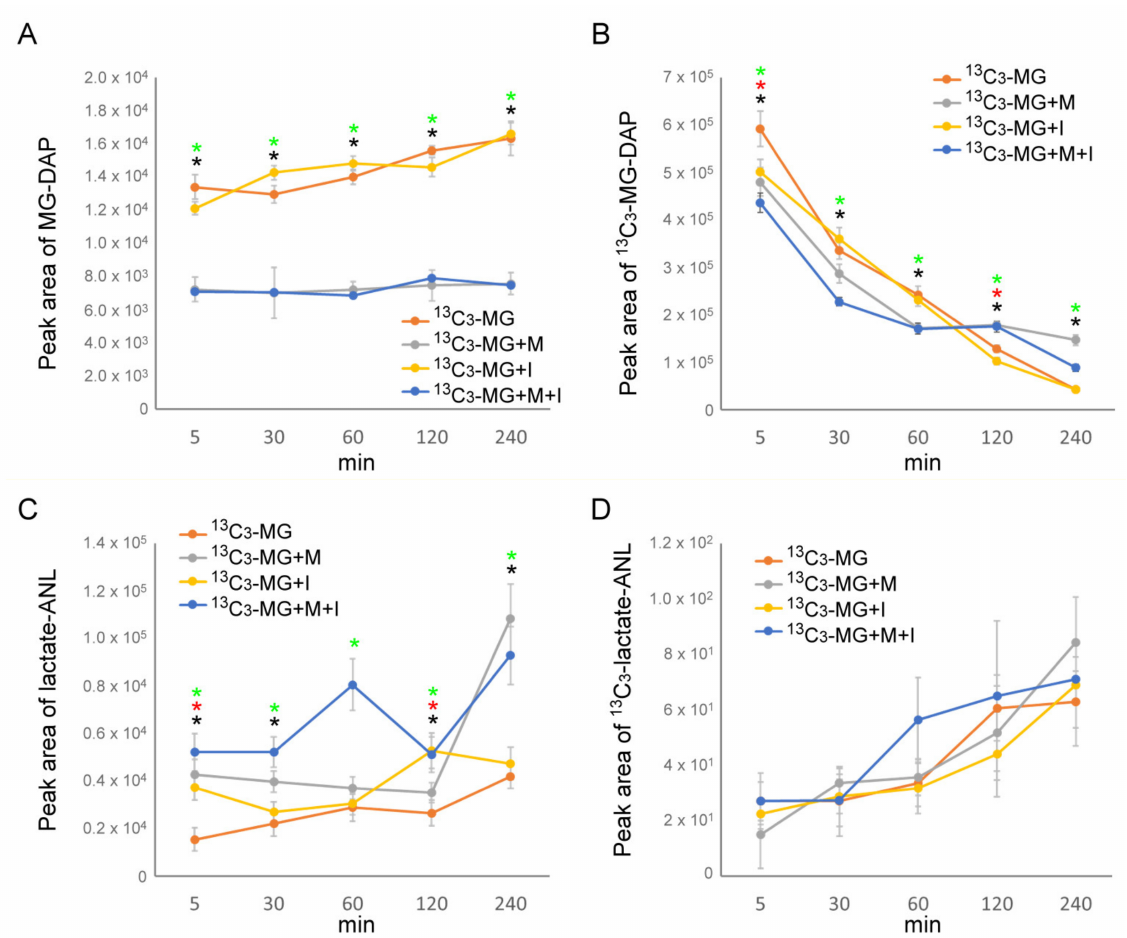
Figure 5. The change of MG and lactic acid in media from insulin- and metformin-treated HEK293T cells. The levels of MG ( A ) MG-DAP, ( B ) 13 C 3 -MG-DAP, ( C ) lactic acid, and ( D ) 13 C 3 -lactate-ANL in media were determined by LC-ESI-MS by applying 13 C 13 C 13 C µ M 13 C µ M 13 C 3 -MG for tracking within 4 h incubation. 3 -MG: 80 3 -MG; 3 -MG+M: 80 3 -MG + 10 mM metformin; 13 C 13 C µ M 13 C µ M 13 C 3 -MG+I: 80 3 -MG + 10 ng/mL insulin; 3 -MG+M+I: 80 3 -MG + 10 mM metformin + 10 ng/mL insulin. Results with a significant difference at p < 0.05 are indicated by * 13 C 3 -MG+M, * 13 C 3 -MG+I, and * 13 C 3 -MG+M+I compared to 13 C 3 -MG-treated cells ( n =